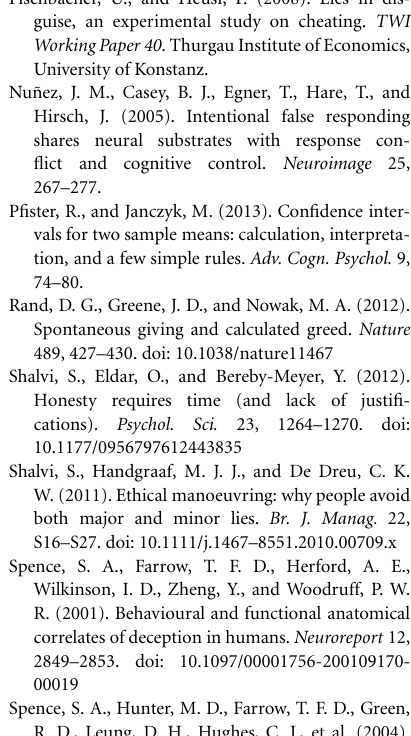
experiment,participantsreportedhigheroutcomesin thedelayedreport conditionthan in the immediate reportcondition,whereasthe conditionsdid notdiffer in the secondhalf. Error bars representstandard errors for paired differences,computedseparately for each half (Pfister andJanczyk,